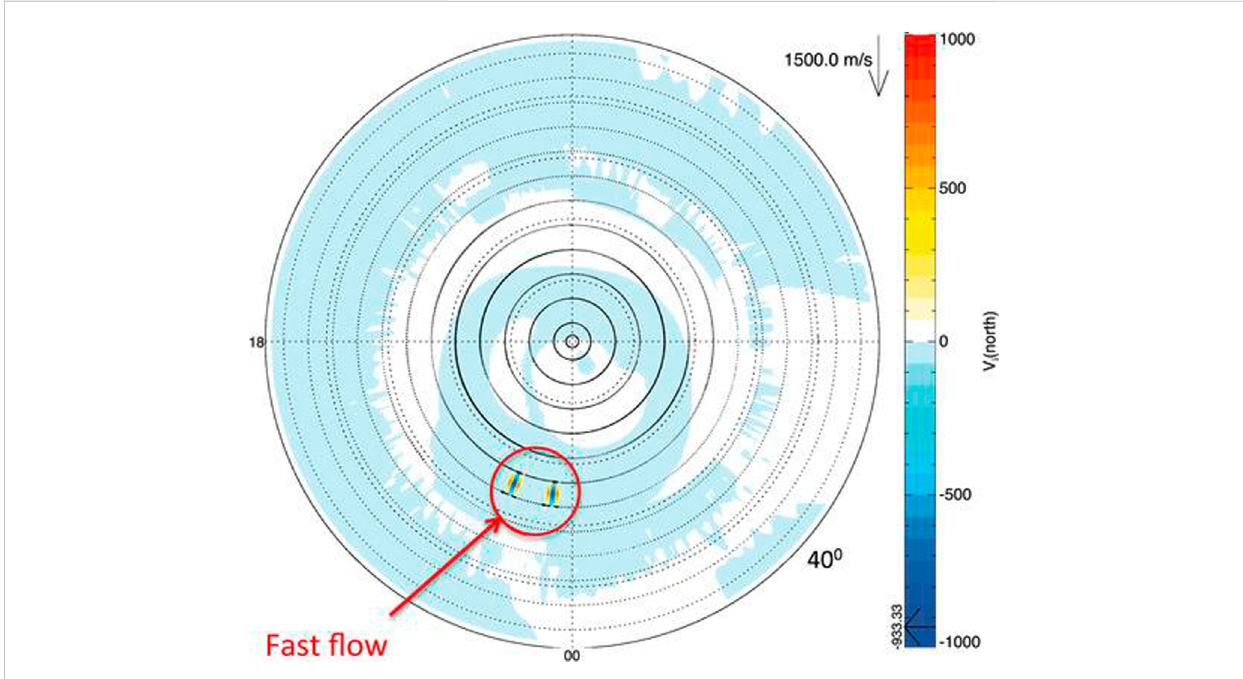
FIGURE 7 FromDengetal.(2019).Two fl owburstswereaddedtoGITMintheauroralzoneandareseparatedby15 ° inlongitudeor1 hinLocalTime.Thereisa high probability for multiple fl ow bursts to happen simultaneously in the auroral zone (Sergeev et al., 2004). Color is the difference in the ion drift in the north direction between the simulations with and without fl ow